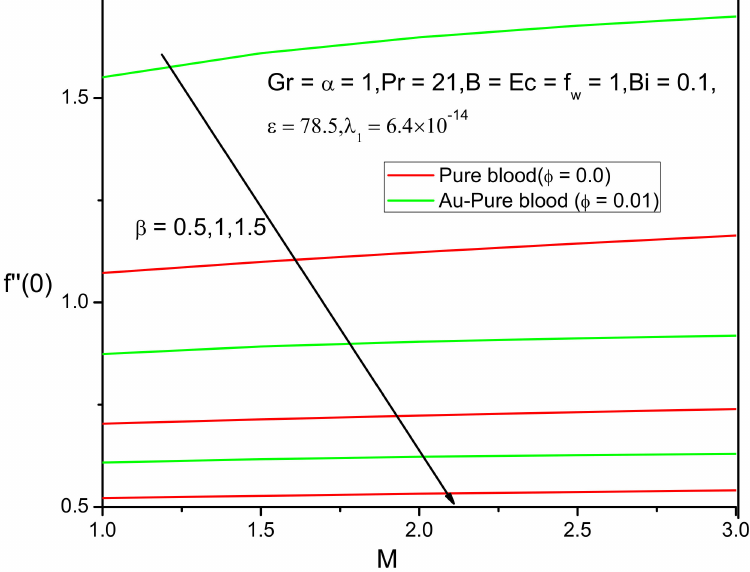
Figure 25. Skin friction coefficient f (cid:48)(cid:48) ( 0 ) with M for different values of β